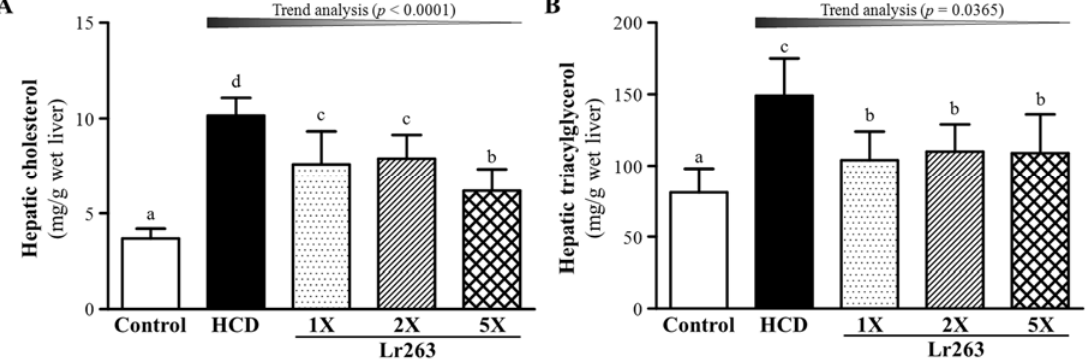
Figure 5. Effect of six-week supplementation with Lr263 on hepatic TC ( A ) and TG ( B ) levels in hyperlipidemic hamsters. Data are the mean ± SD, n = 8 hamsters in each group. Columns with different letters (a, b, c, d) significantly differ at p < 0.05 by a one-way